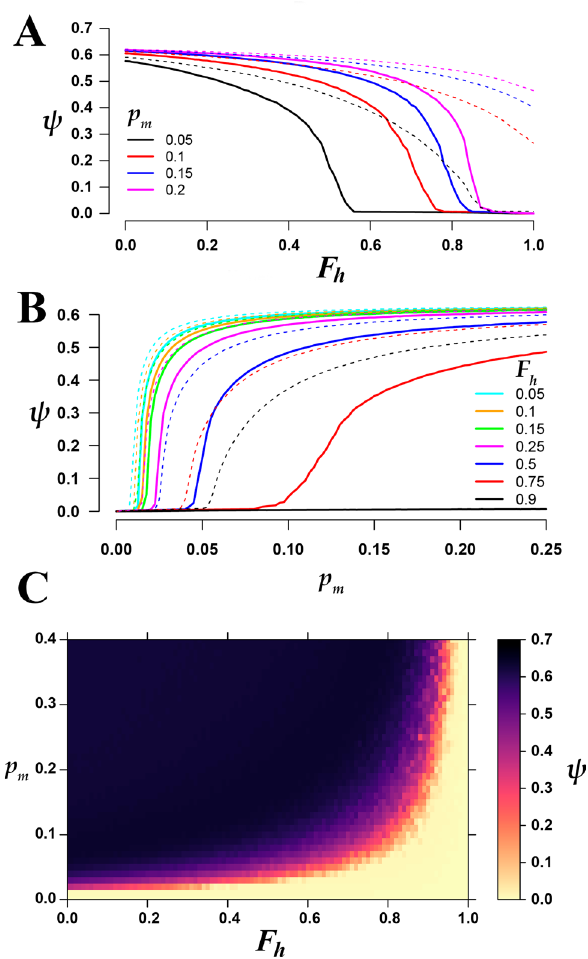
Figure 4. Phase transition. ( A ) Phase transition of the crime incidence ψ as a function of the fraction F h = 1 − F c of honest police officers ( F c is the fraction of corrupt officers). The solid curves correspond to different values of the maximum turning probability p m with no inflated corruption perception ( α = 0 ). The dashed-broken lines correspons to the same values of p m , but with an increased perception of corruption α = 0.2 . ( B ) Phase transition of ψ as a function of the turning probability p m for different values of F h and α = 0 (solid lines), and for α = 0.2 (dashed-broken lines). ( C ) Heat map of the phase transition as driven by both F h and p m for α = 0 . Note that the phase transition is remarkably sensitive to changes in p m as compared to changes in F h . All the simulations were performed for systems with N = 10 5 agents, 1% of which